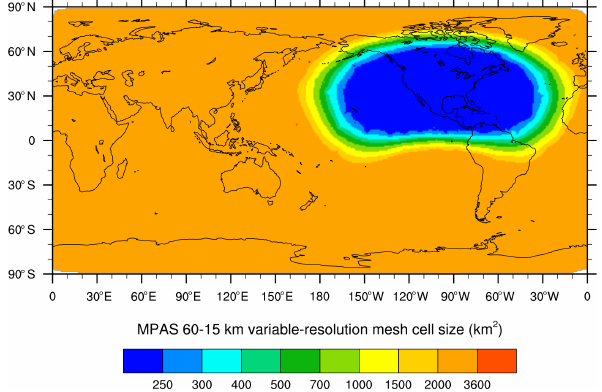
Figure 1. Variable-resolution 60–15km global domain for MPAS- A CO 2 simulations conducted for model evaluation using aircraft and near-surface CO 2 observations. The highest-resolution (15km) grid covering the most of North America has a cell size of less than 250km 2 . The cell sizes (represented by color) gradually increase to about 3600km 2 for the rest of the global domain.